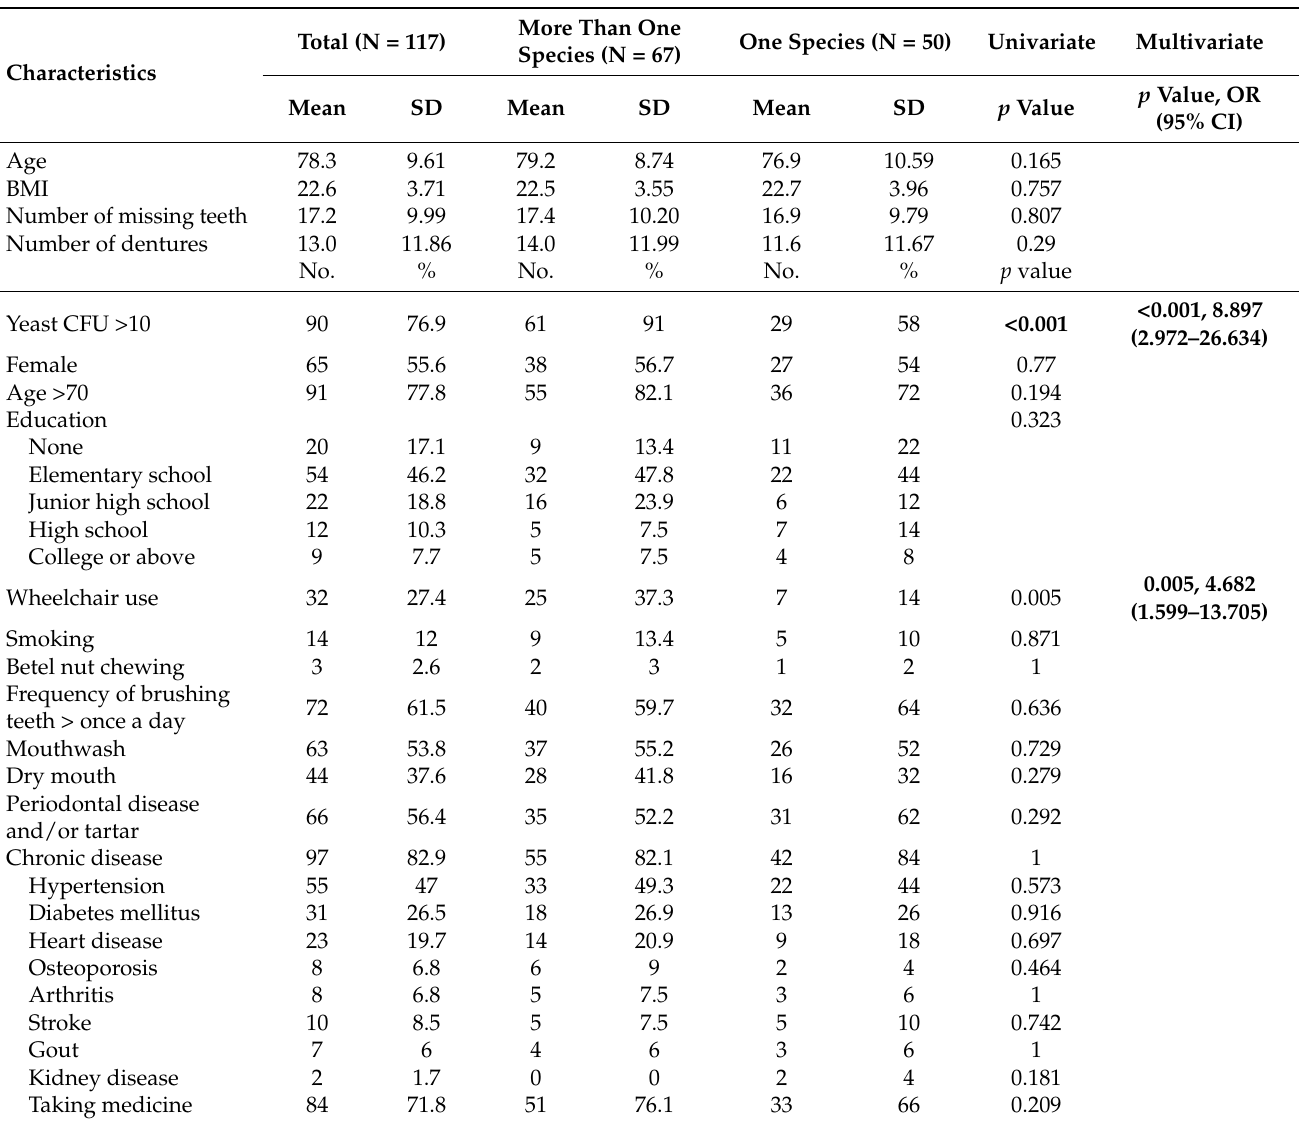
Table 2. Risk factors of residents colonized by multiple